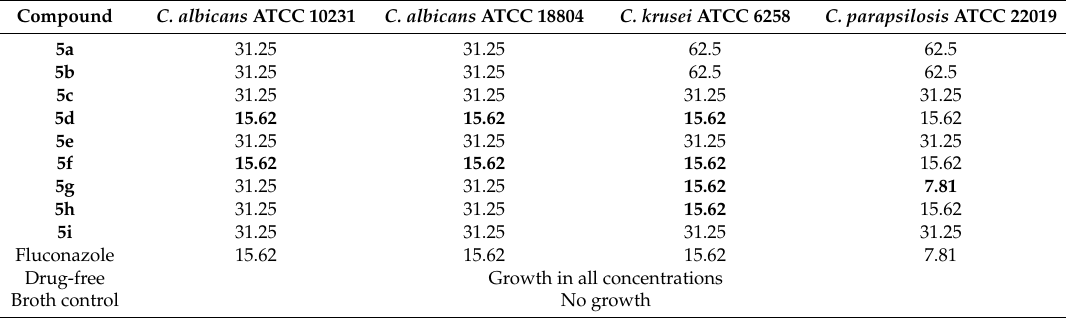
Table 1. The minimum inhibitory concentration values (MIC, µ g/mL) of the newly synthesized compounds 5a – i against all tested Candida